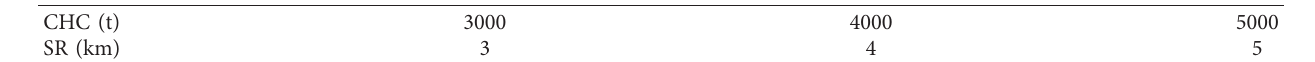
Table 4: Parameter settings for CHC and